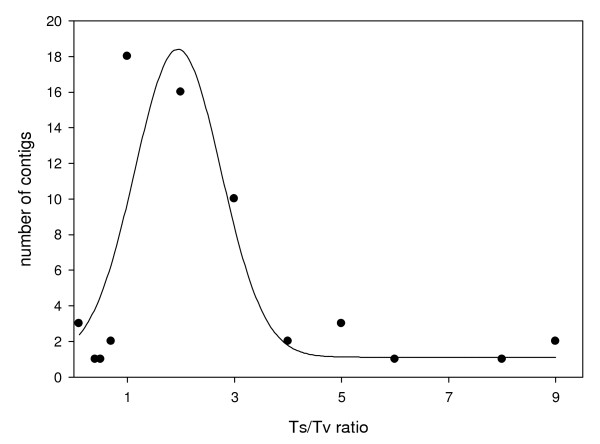
Frequency plot of Ts/Tv ratios for 60 contigs with a significant BLAST hit. Points represent the number of contigs with that specific Ts/Tv ratio. Ts/Tv ratios greater than 1 indicate an excess of transitions, those lower than 1 indicate an excess of transversions. A line of best fit is plotted through the data.